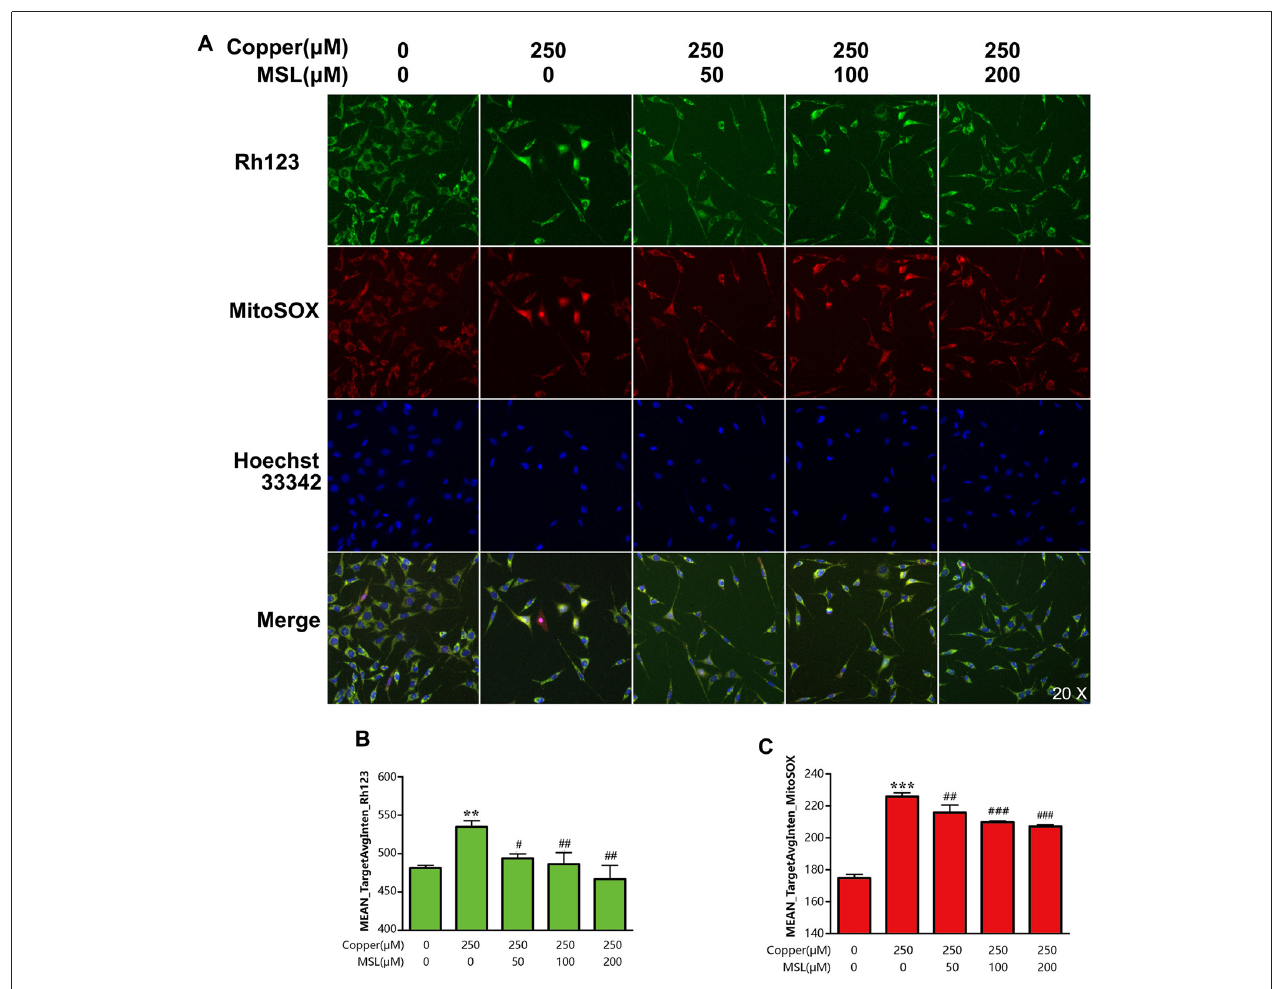
FIGURE 4 | MSL alleviated mitochondrial dysfunction of copper-induced APPsw cells. (A) Mitochondrial ability was assessed by mitochondrial membrane potential (MMP) and superoxide levels. Fluorescent images of Rh123 and MitoSOX indicated the changes of MMP and superoxide, respectively. Fluorescent images and intensities were analyzed by a Cellomics ArrayScan high-content screening (HCS) Reader and software. Quantified values of Rh123 (B) and MitoSOX (C) were analyzed by Mean_Avginten. Data are expressed as the mean ± SEM, n = 6, ∗∗ p < 0.01, ∗∗∗ p < 0.001 vs. untreated cells; # p < 0.05, ## p < 0.01, ### p < 0.001 vs. copper-treated